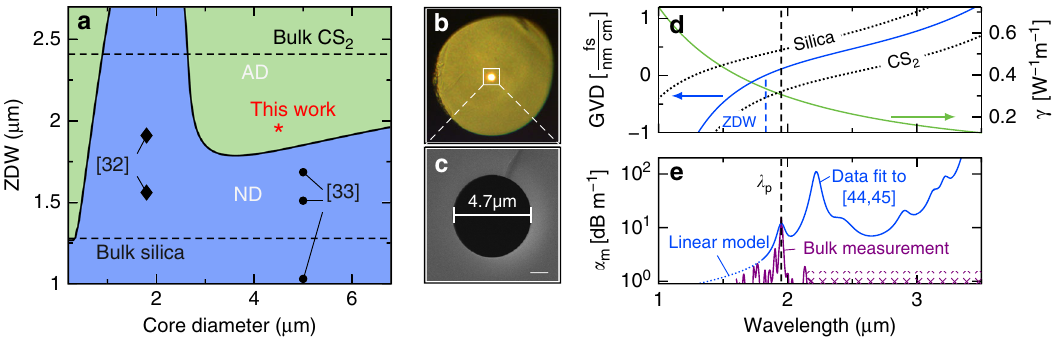
Fig. 4 Optical properties of CS 2 /silica step-index fi bres. a GVD map: the spectral position of the ZDW for various core diameters (at 20 °C, 1 atm). AD anomalous dispersion, ND normal dispersion. The black marks indicate the work by other groups reported earlier. The red star refers to the experiments reported here. b Transmission microscope picture of a fi lled liquid-core step-index fi bre and c electron microscope image of the capillaries used in this work. d GVD and nonlinear coef fi cient of the fundamental mode (HE 11 ) of the CS 2 /silica fi bre. e Estimated modal attenuation coef fi cient α m compared